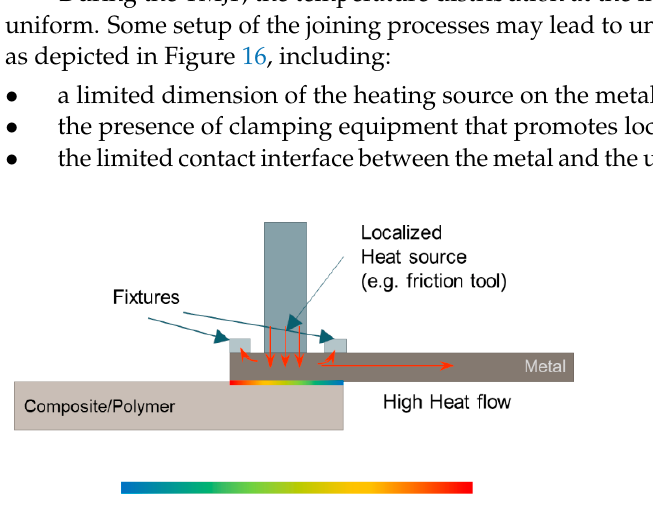
Figure 15. Schematic of the adherends surfaces: ( a ) Before joining; ( b ) Insufficient; ( c ) Correct and ( d ) Excessive material flow.